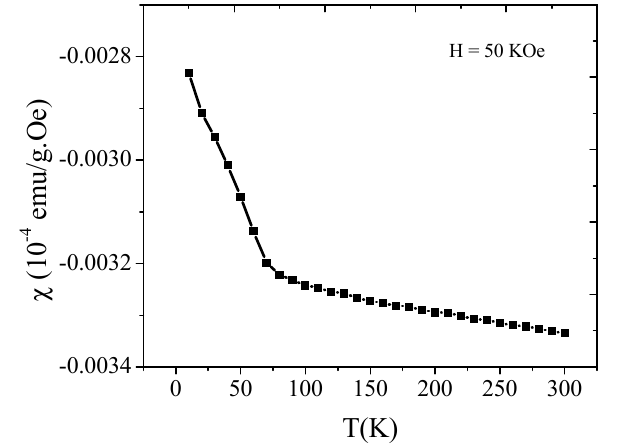
Figure 10. Magnetic susceptibility χ (T) measured at 50 KOe .